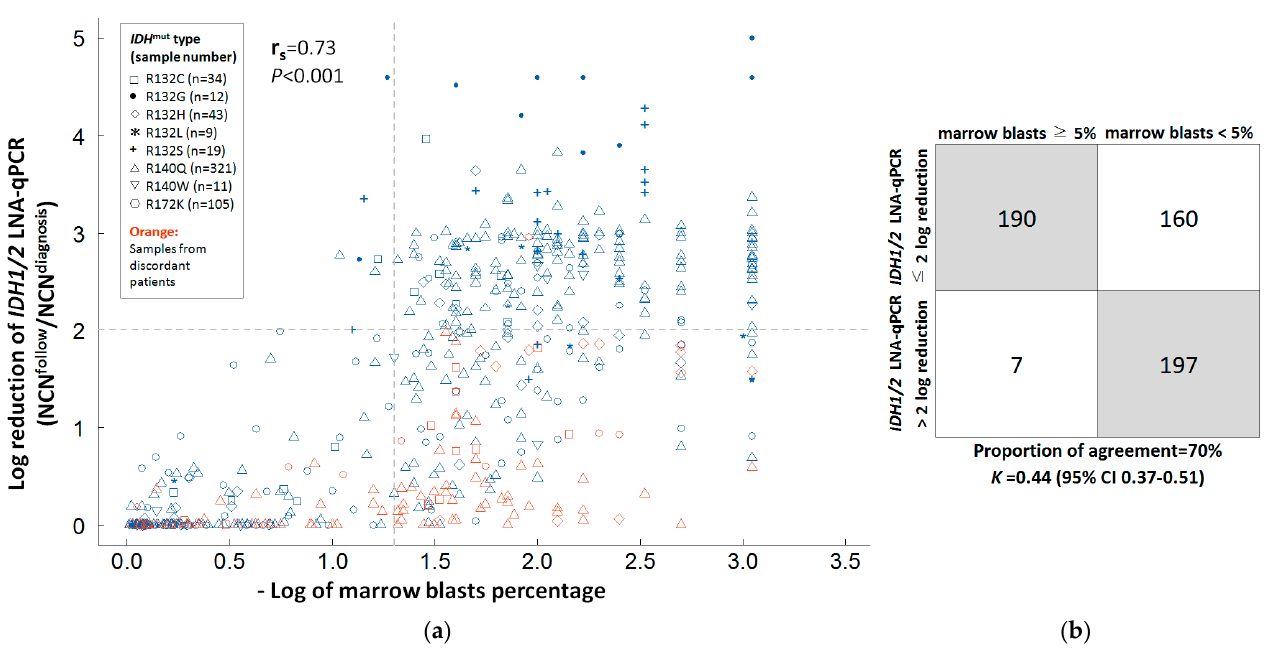
Figure 3. Correlation and agreement between IDH1/2 LNA-qPCR MRD and marrow blasts in serial bone marrow samples. ( a ) Correlation between IDH1/2 LNA-qPCR MRD and marrow blasts by log reduction. Gray dashed lines showed two-log reduction of IDH1/2 LNA-qPCR and 1.3-log (5%) of marrow blasts percentage. Orange points represent samples from patients with discordant reduction of IDH1/2 LNA ‐ qPCR in complete remission status. Blue points represent samples from patients with regeneration marrow. ( b ) Agreement between IDH1/2 LNA ‐ qPCR MRD and marrow blasts of all samples.